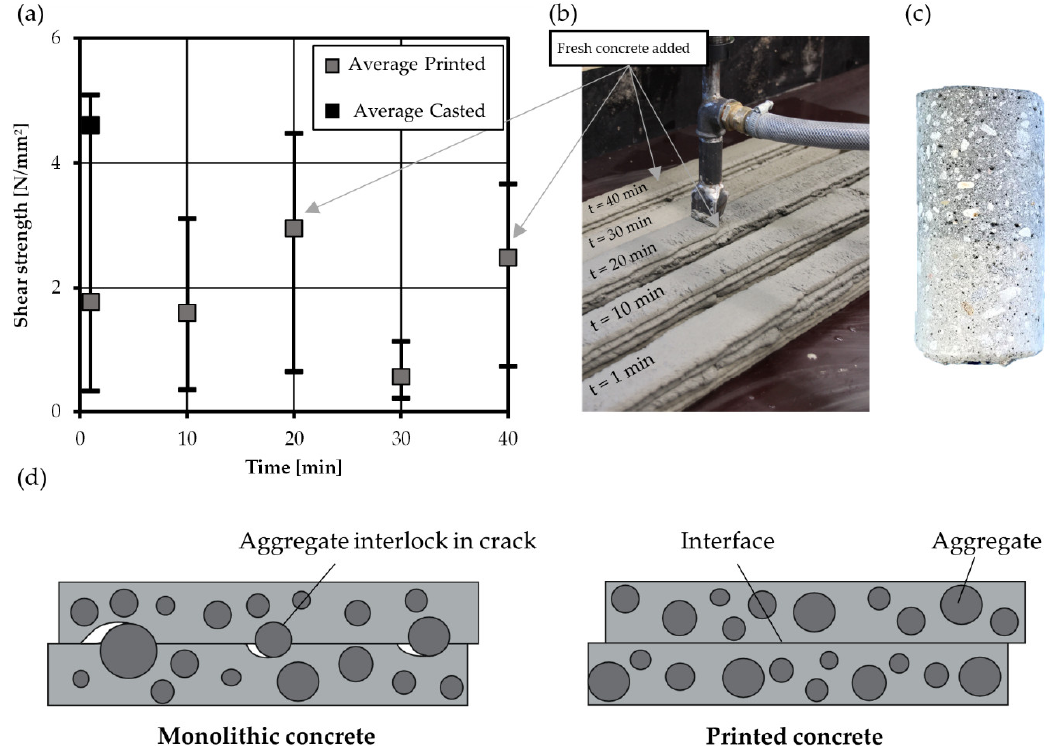
Figure 13. Results of shear test on printed specimen and values of ( a ) shear strength and ( b ) printing process and instants of adding fresh concrete (20 min, 40 min), ( c ) specimen and ( d ) aggregate distribution in monolithic and printed concrete.